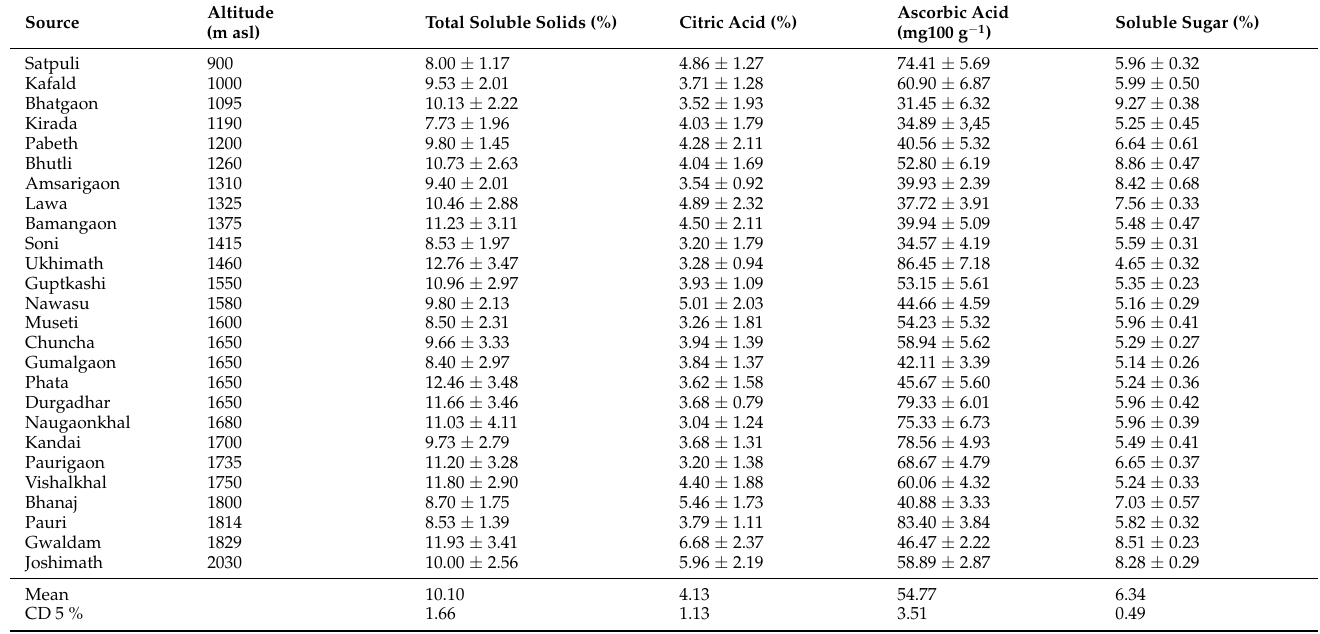
Table 3. Effect of altitude on nutrients content (mean ± SD) of C. sinensis in Garhwal Himalaya.